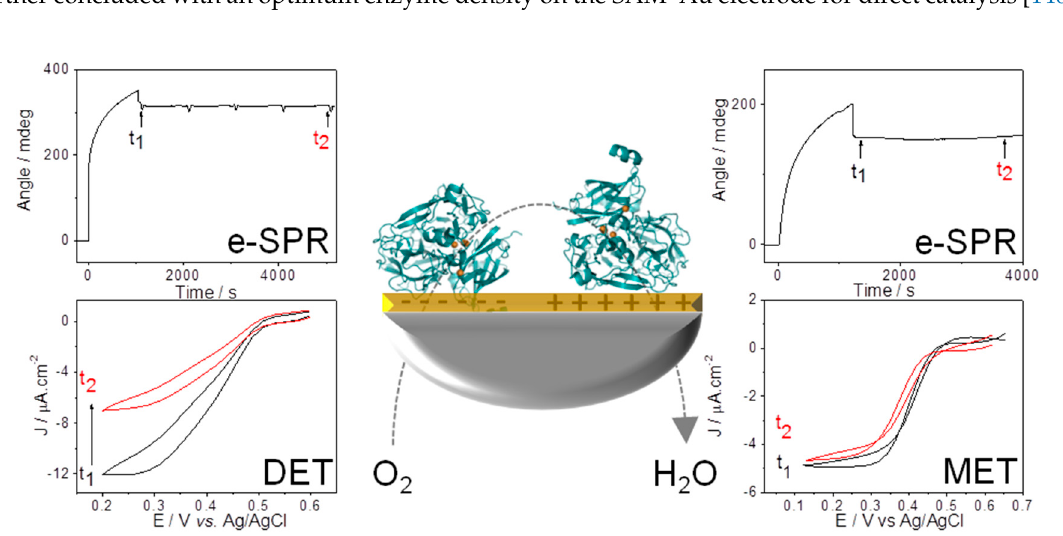
Figure 7. Coupling SPR with electrochemistry allowed the demonstration of a different orientation of the M. verrucaria bilirubin oxidase (BOD) according to the charge of the electrode controlling the type of ET process for enzymatic O 2 reduction. On either positive ( Right ) or negative ( Left ) SAM-modified gold electrodes, surface adsorption of the enzyme is successful. However, negatively charged SAM ( Left ) allows direct ET (DET), while positively charged SAM ( Right ) requires a redox mediator for catalysis (MET). Adapted from [145].